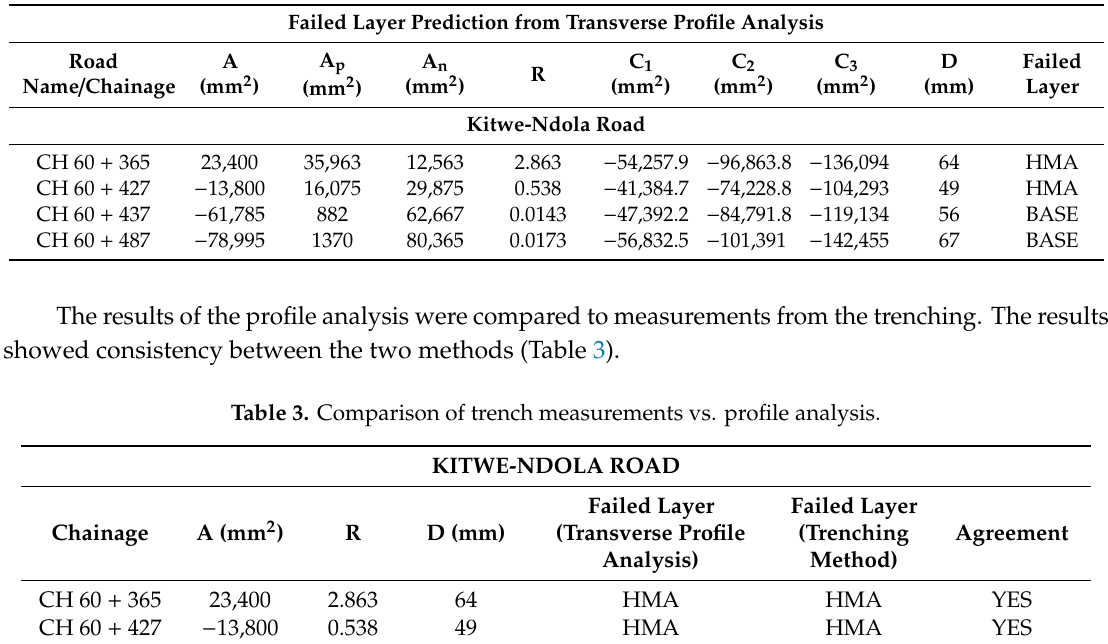
Table 2. Kitwe-Ndola Road profile analysis.